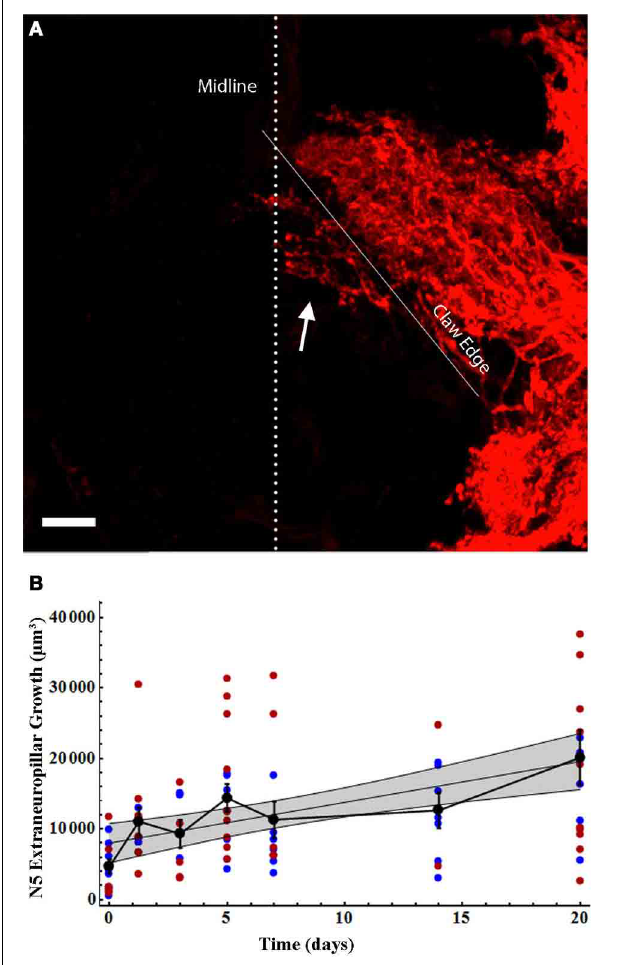
FIGURE 5 | N5 extraneuropillar growth increased in the same linear pattern for males and females following deafferentation. (A) Total N5 growth consisted of the axons crossing the midline (dotted line) as well as the axons crossing the bottom edge of the anterior portion of the claw (solid white line) to extend outside of the neuropil (arrow). The volume of this extraneuropillar growth was measured. The N5 image shown belongs to a 7 days deafferent. Scale bar = 20 µ m. (B) Male (blue) and female (red) N5 extraneuropillar growth data sets increased linearly and were not significantly different from one another. Black data points represent means, and error bars represent standard error of the mean. Female N5 extraneuropillar growth control ( n = 7), 30h ( n = 6), 3 days ( n = 5), 5 days ( n = 10), 7 days ( n = 6), 14 days ( n = 2), and 20 days ( n = 10). Male N5 extraneuropillar growth control ( n = 9), 30h ( n = 6), 3 days ( n = 3), 5 days ( n = 7), 7 days ( n = 6), 14 days ( n = 7), and 20 days ( n = 7). The shaded gray area represents the 95% confidence interval. See Table 2 for regression equations and